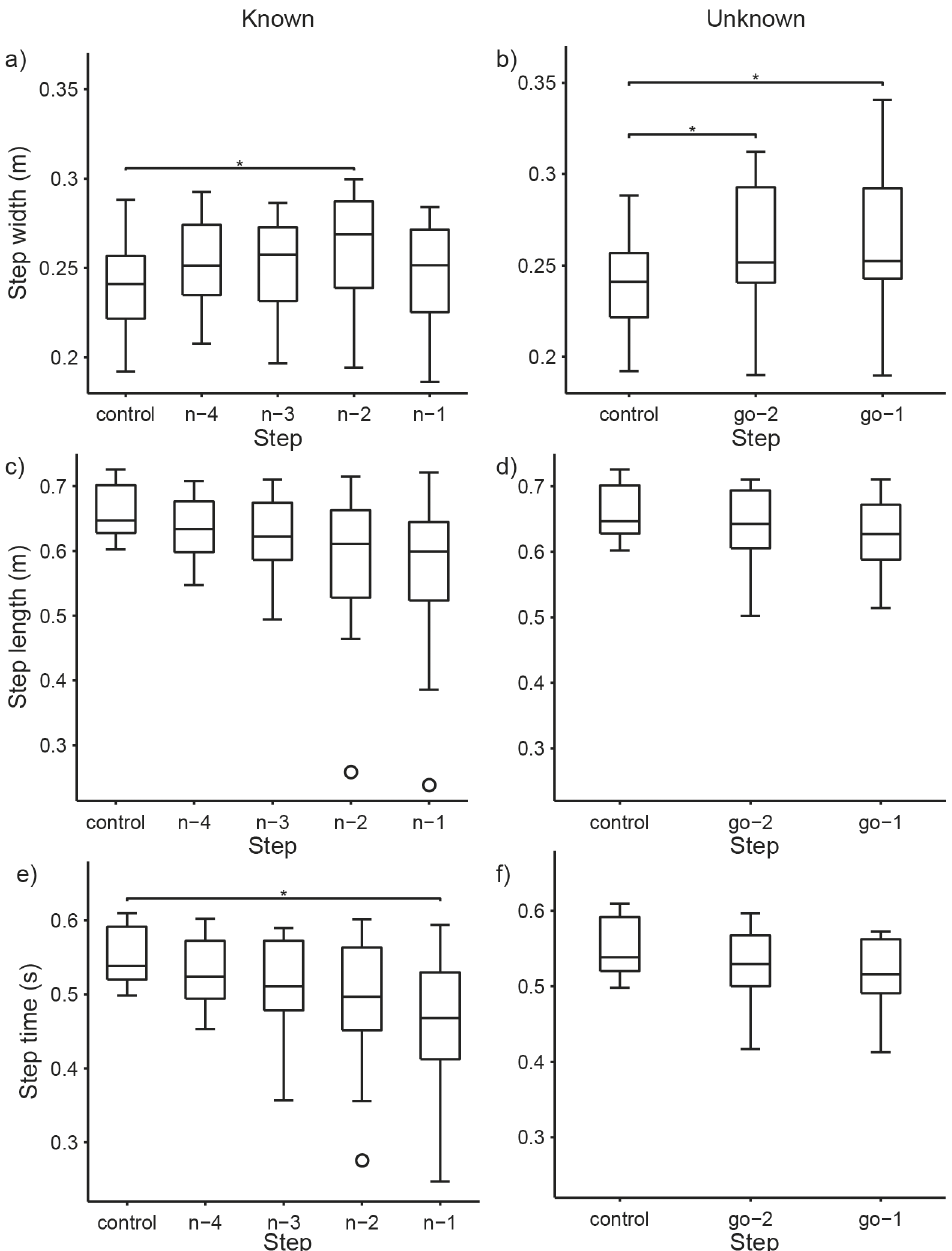
Fig 4. Step Width, Step Length, and Step Time. Each box plot is collapsed across limb side to show main effect of step on step width, step length and step time. Each box represents 14 subjects ’ data. a) Step width, Known condition. The n-2 step width was significantly larger than the control step (contralateral